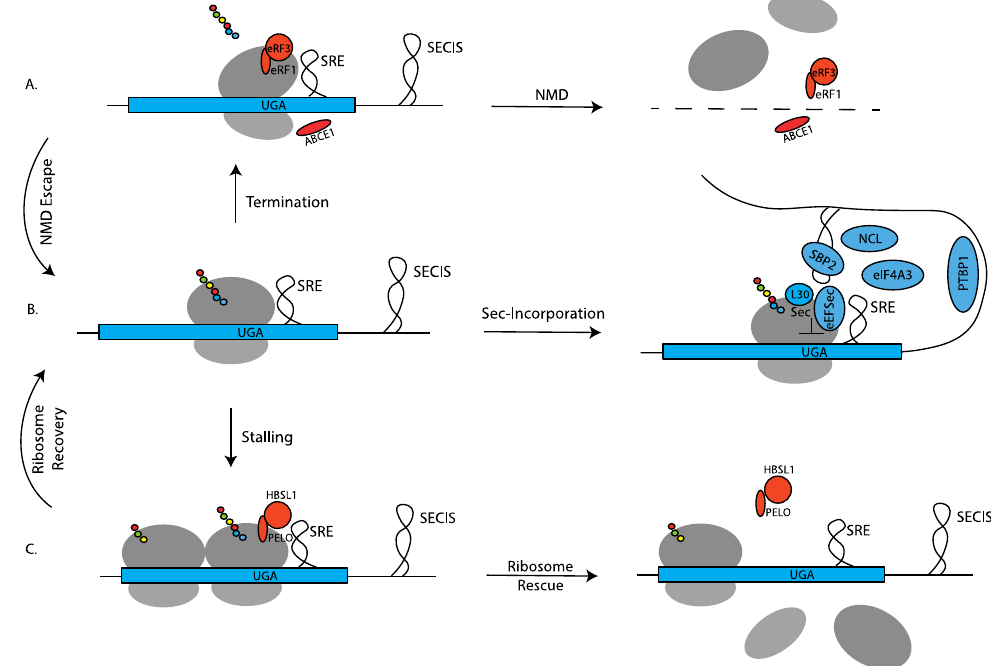
Figure 2. Possible fates of ribosomes encountering UGA-Sec codons. ( A ) Ribosomes failing to incorporate Sec may prematurely terminate translation, leading to nonsense-mediated decay (NMD) or NMD escape and continued translation by ribosomes located upstream of the UGA codon. ( B ) Sec- incorporation mediated by Sec insertion machinery. ( C ) Ribosomes that fail to incorporate Sec or terminate may be subject to various translational quality control pathways leading to ribosome release or